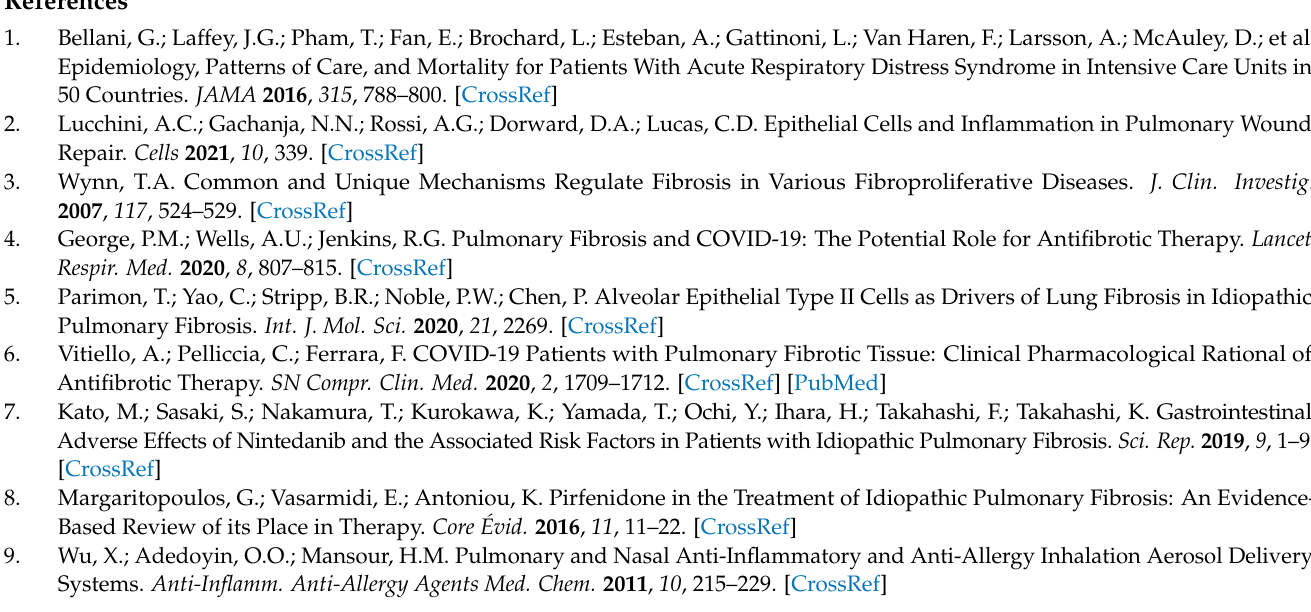
chemical structure, Figure S3: Curcumin suspensions, Table S1: SAXS’ model parameters obtained from nonlinear least squares procedure, Figure S4: Nanovesicles stability upon storage, Figure